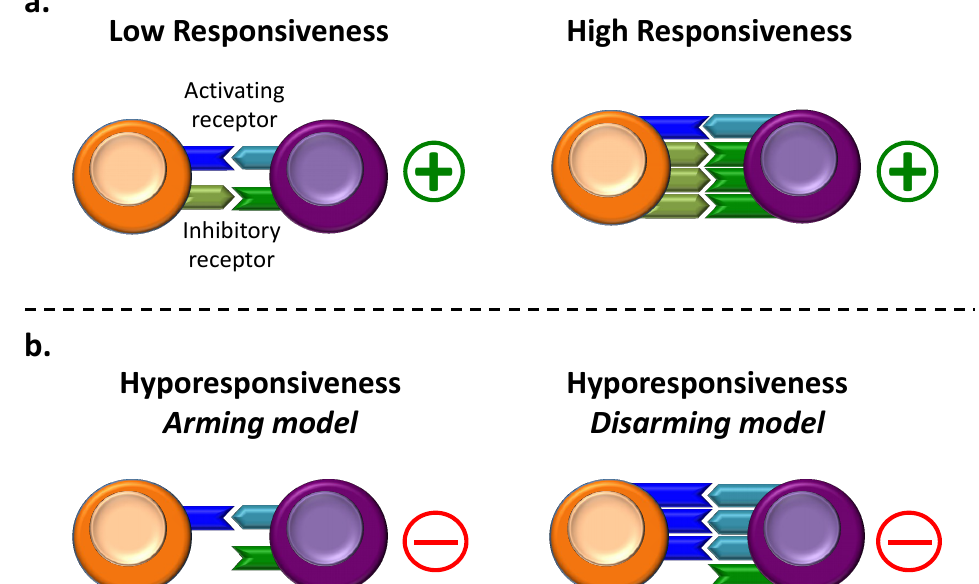
Figure 1. Natural Killer (NK) cell hyporesponsiveness during the education process. ( a ) Left. NK cells acquire functional maturation during development. The appropriate integration of inhibitory and activating signals determines the outcome of interactions to target cells. Right. High responsiveness (green plus) of NK cells after encountering several inhibitory receptor ligands during development. ( b ) NK cell hyporesponsiveness (red minus) could occur by (left) the absence of inhibitory signals or (right) an increased activating stimulation.